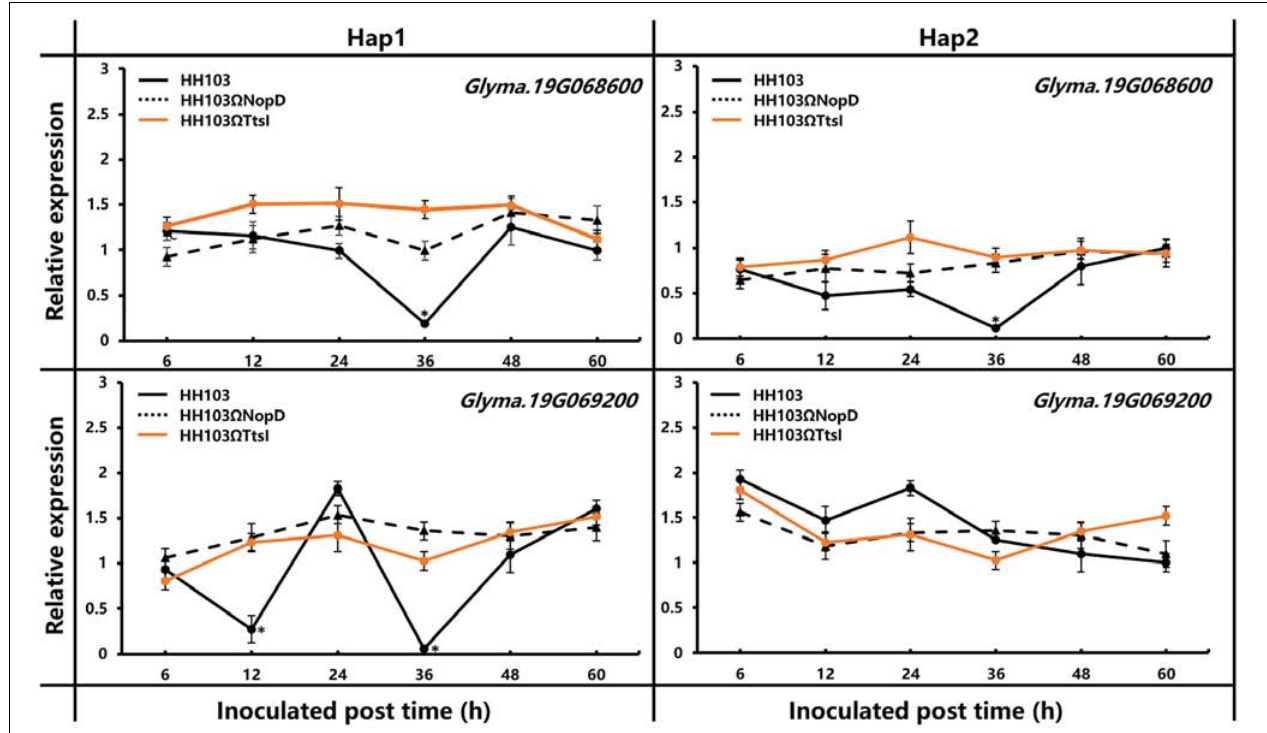
FIGURE 8 | Relative expression of Glyma.19g066800 and Glyma.19g069200 was measured by qRT-PCR in RNA extracted from roots of Hap1 and Hap2 accession plants inoculated with S. fredii HH103 wild-type or mutants HH103 (cid:127) NopD and HH103 (cid:127) TtsI . Uninoculated soybean plants were used as the control. The 2 − (cid:49)(cid:49) Ct method was used to calculate the relative expression levels of candidate genes. Error bars indicate the mean ± standard error of three replications. Significant differences were determined by t -tests, and ‘*’ indicated the significant differences ( p ≤ 0.05) at the time